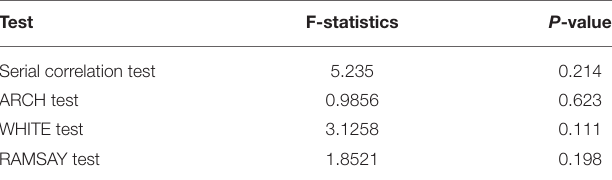
TABLE 8 | Model stability